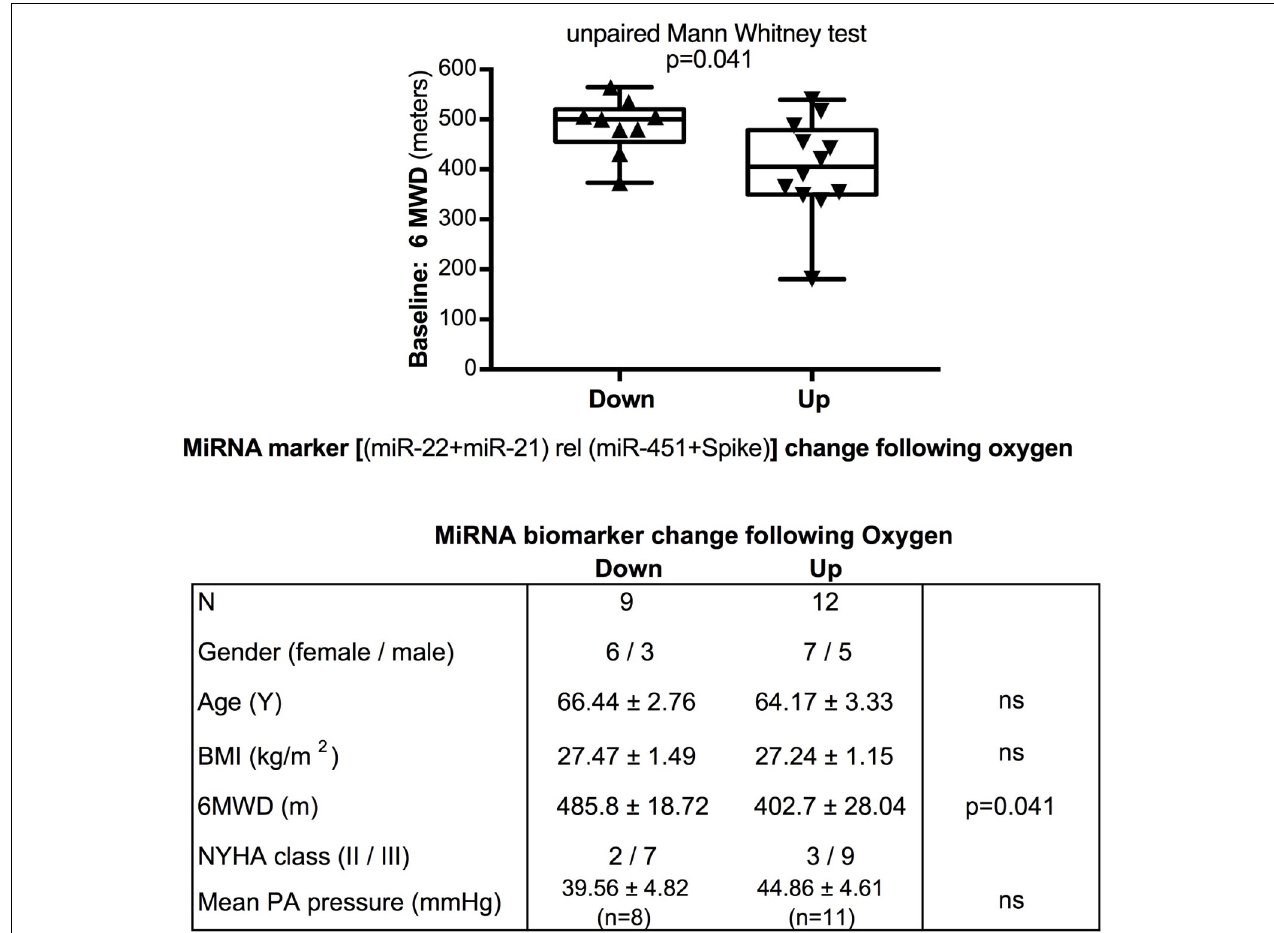
FIGURE 5 | Baseline 6-min walking distance in the oxygen intervention study – comparison with directional change of the miRNA marker. Box-plots with whiskers and individual points show 6-min-walking-distance (6MWD, m) measured at baseline examination from patients in the oxygen intervention study. The data were grouped by the directional change of the miR-22-3p + miR-21-5p relative to spike-RNA + miR-451a (10,000 × ) values after oxygen versus placebo: down or up, as shown in Figure 4D . Groups were compared with the unpaired, 2-tailed Mann–Whitney test; p < 0.05 was considered significant, ns is not significant. The table graph lists the characteristics of the sample donors for each